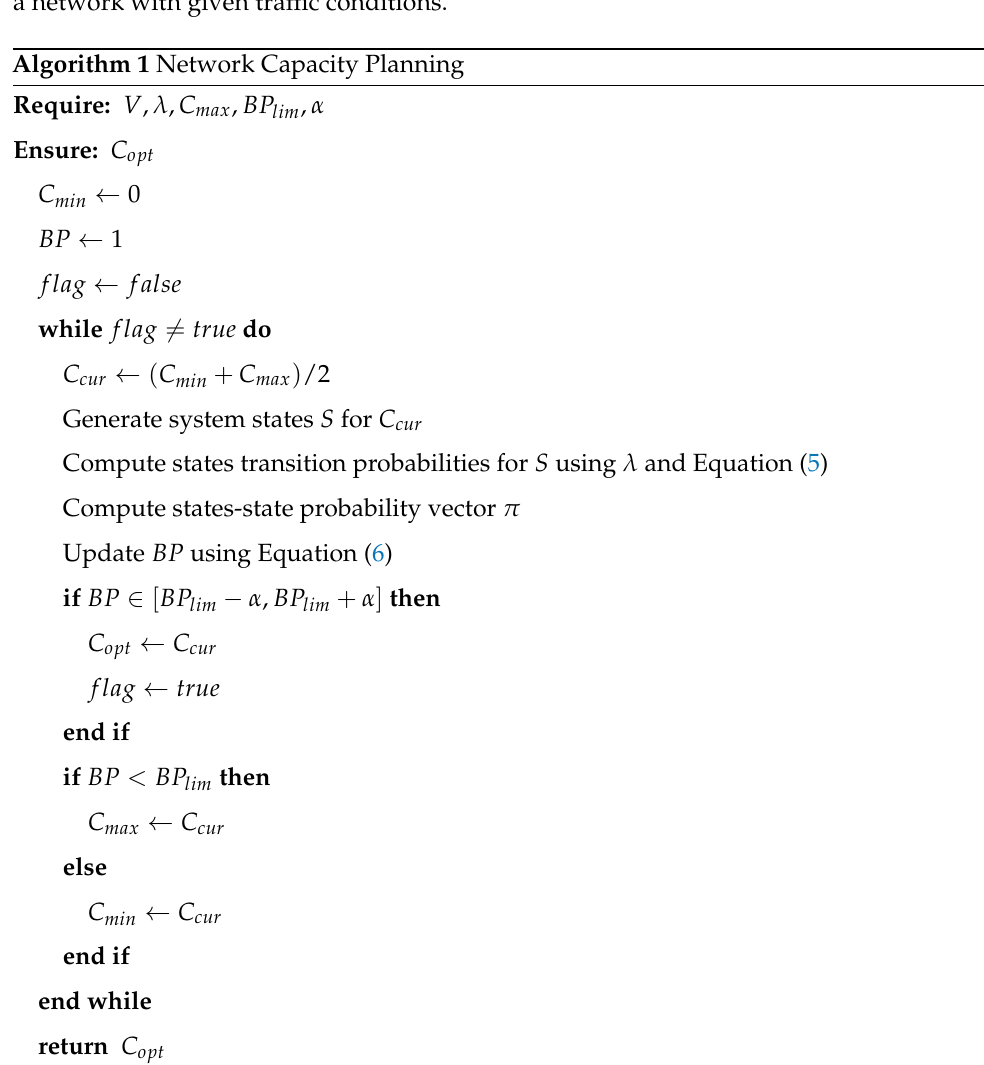
Algorithm 1 Network Capacity